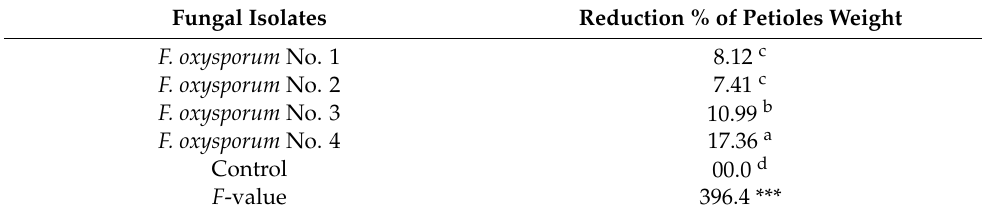
Table 5. Degradation of F. oxysporum isolates on date palm tree.